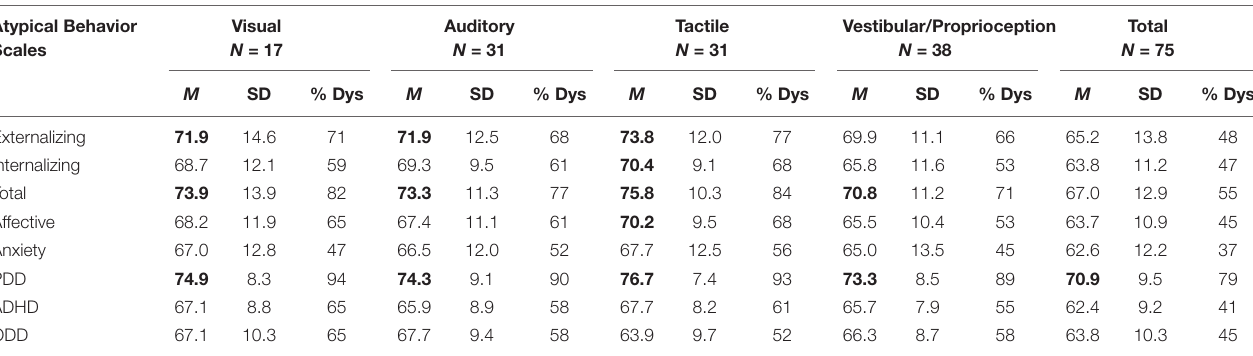
TABLE 2 | Child Behavior Checklist T-scores by sensory system